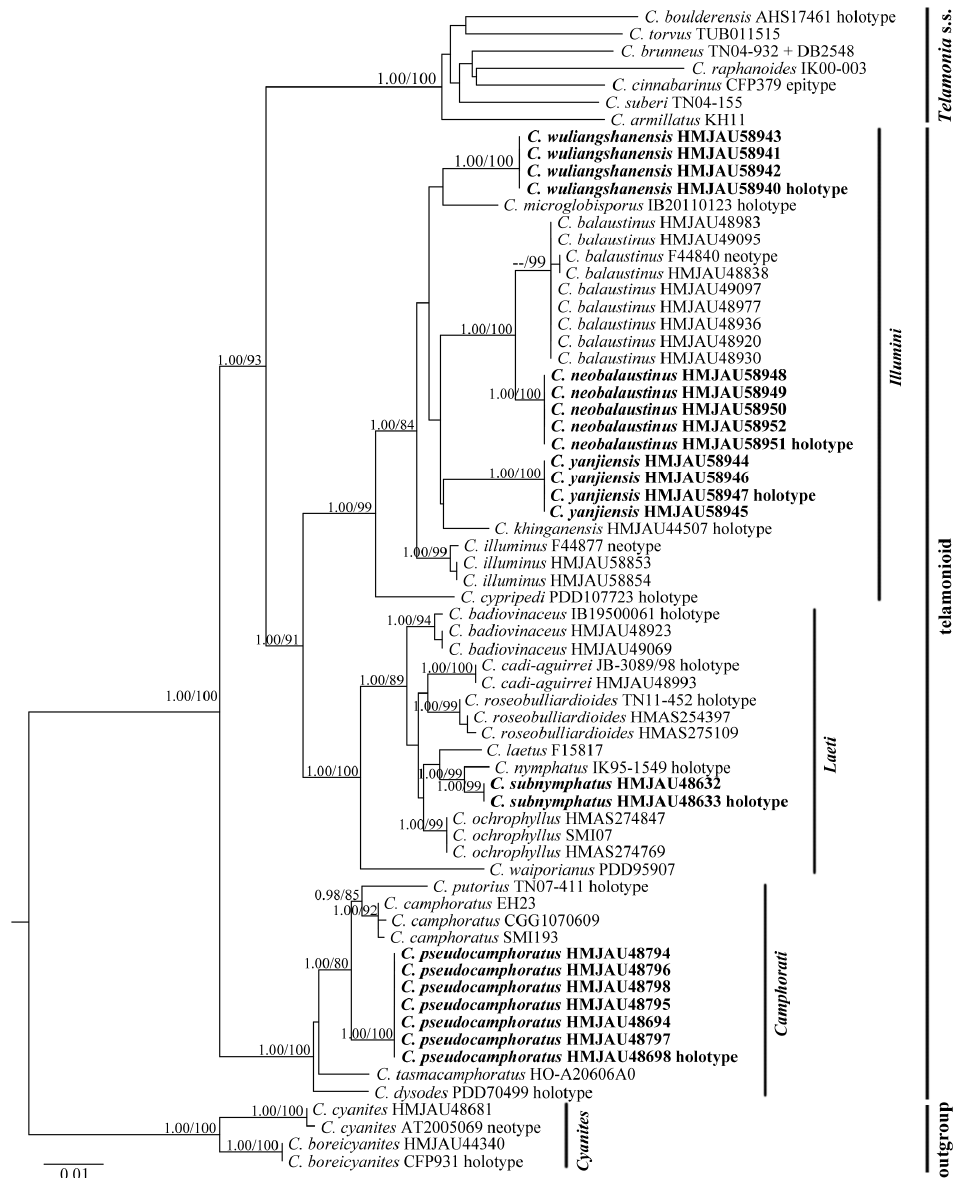
Figure 1. ML phylogram inferred from the ITS + 28S + rpb2 dataset. The tree is rooted with sect. Cyanites . The Bayesian posterior probabilities (BPP) ≥ 0.95 and ML bootstrap values (ML) ≥ 75% are shown on the branches (BPP/ML). New species are marked in black bold font.